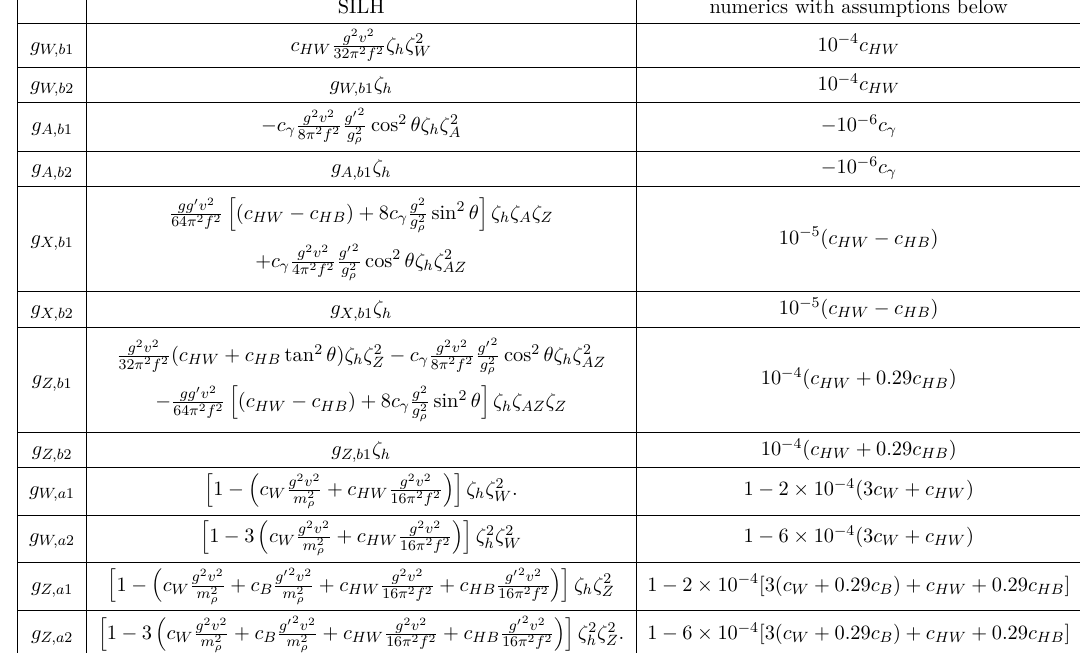
Table 8 . Relations between the phenomenological Lagrangian parameters in (1.1)–(1.3) (first column), the SILH effective Lagrangian (3.1) (second column), The extra parameters ζ n , ζ n (defined in [4, 81]) are induced by the Higgs and gauge-boson wave-function normalization, ζ n A AZ